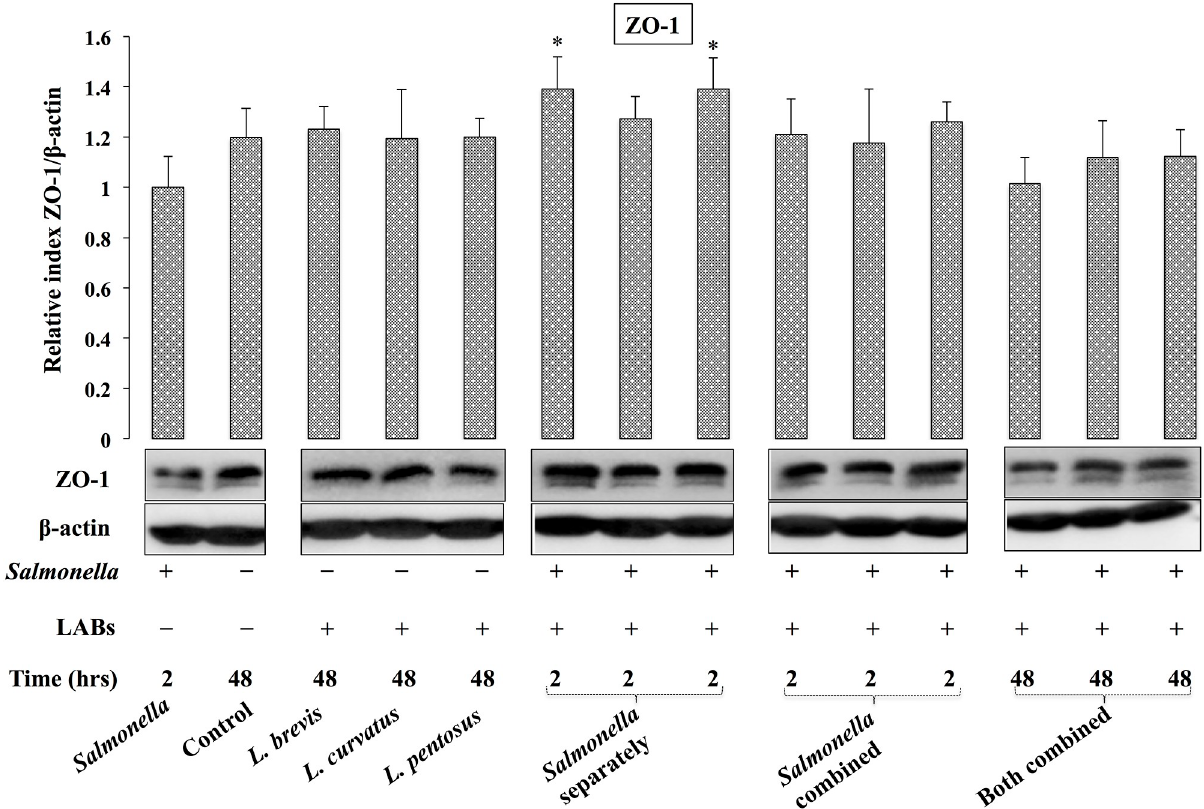
Fig 4. Lactobacillus strains ability to modulate tight-junction protein expression in IECs. HT-29 cells were stimulated as follows: Salmonella alone, medium alone (control), LABs alone, LABs + Salmonella (2 h separately), LABs + Salmonella (2 h combined), and LABs + Salmonella (48 h). The protein level of Zonula occludens-1 (ZO-1) was analyzed by western blot. The image J software used to determine intensities of proteins bands. Significant differences between the groups, � p < 0.05.